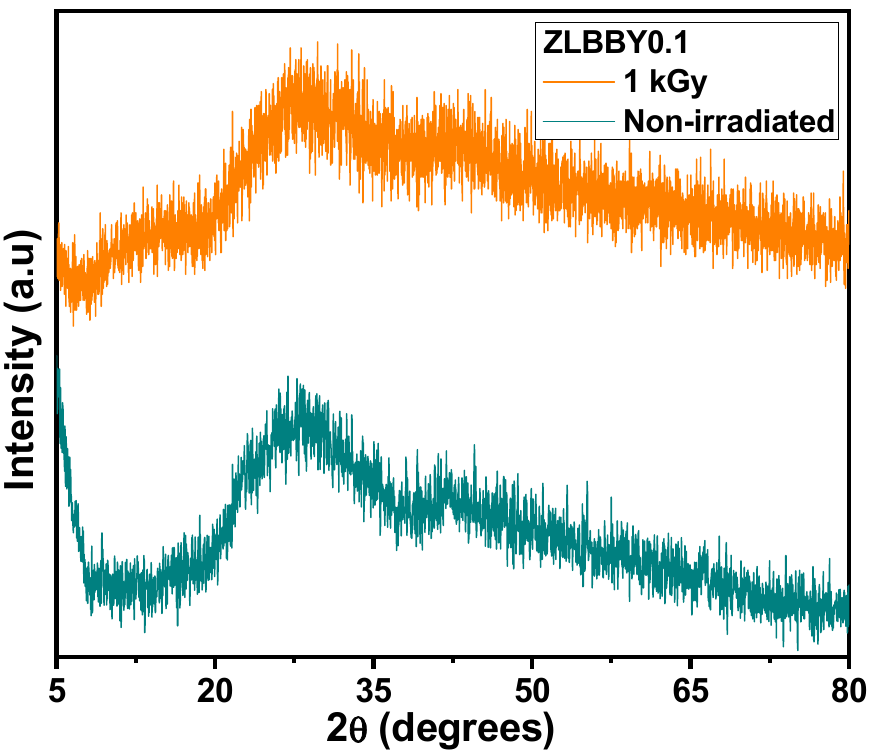
Figure 2. Stacked XRD profiles of the non-irradiated and the 1 kGy 𝛾 -irradiated ZLBBY0.1 glasses.